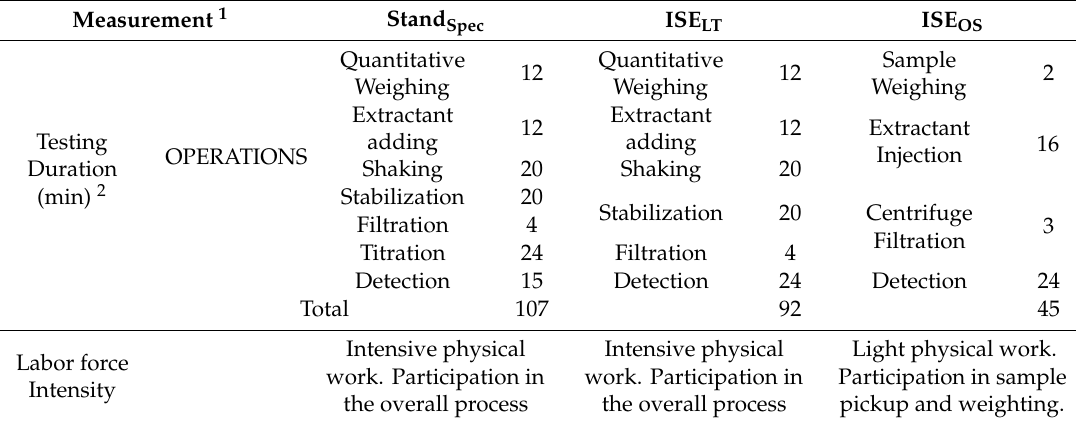
Table 3. Comparison of the testing duration and labor force among Stand Spec , ISE OS , and ISE